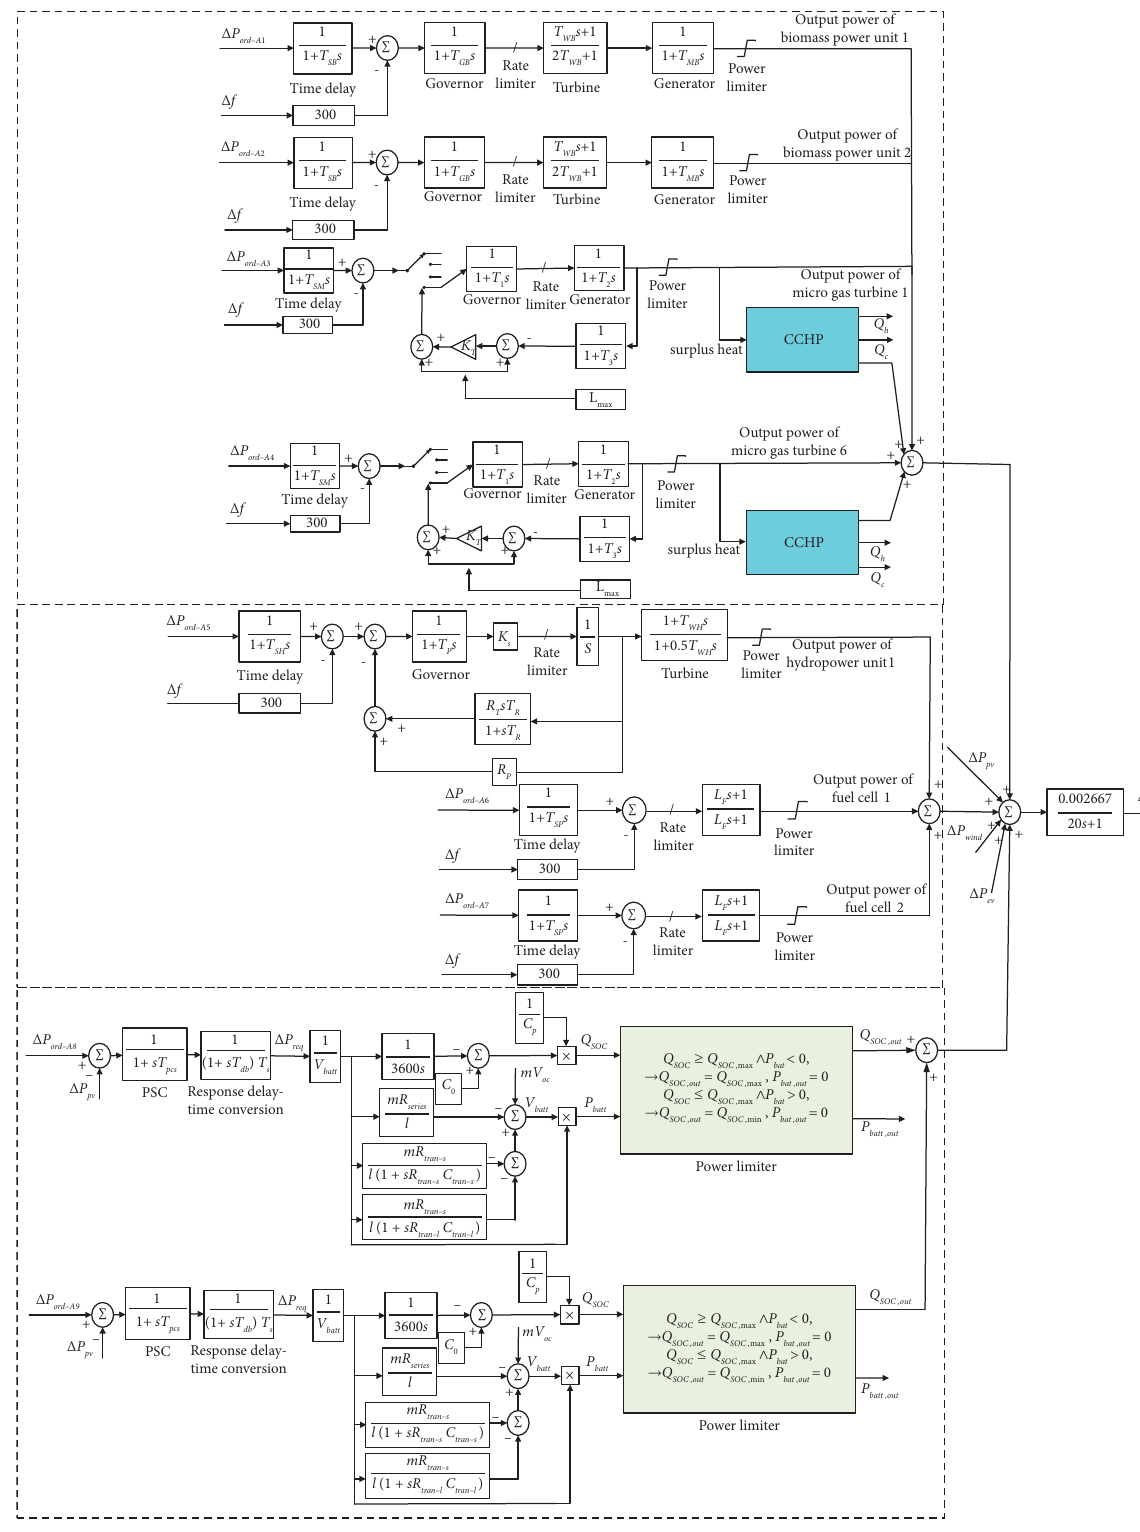
Figure 3: Microgrid